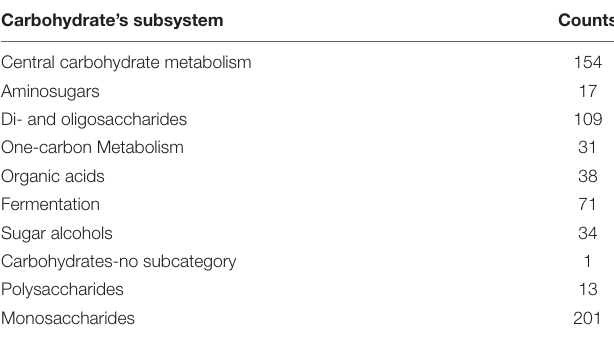
TABLE 1 | KEEG carbohydrates metabolic pathway genes identified Rahnella sp. ChdrAdgB13